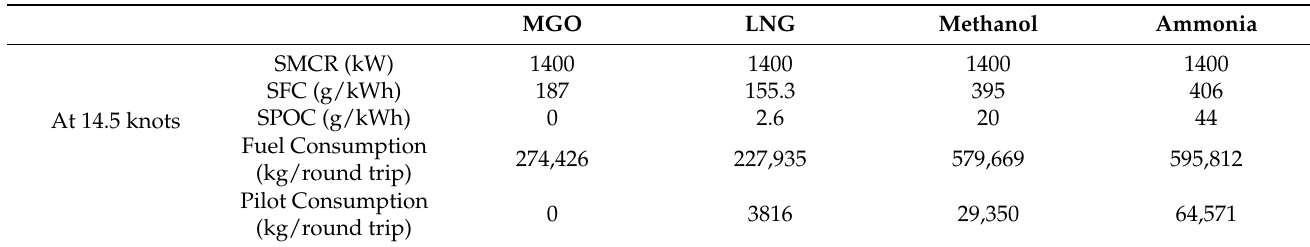
Table 5. The AEs’ fuel